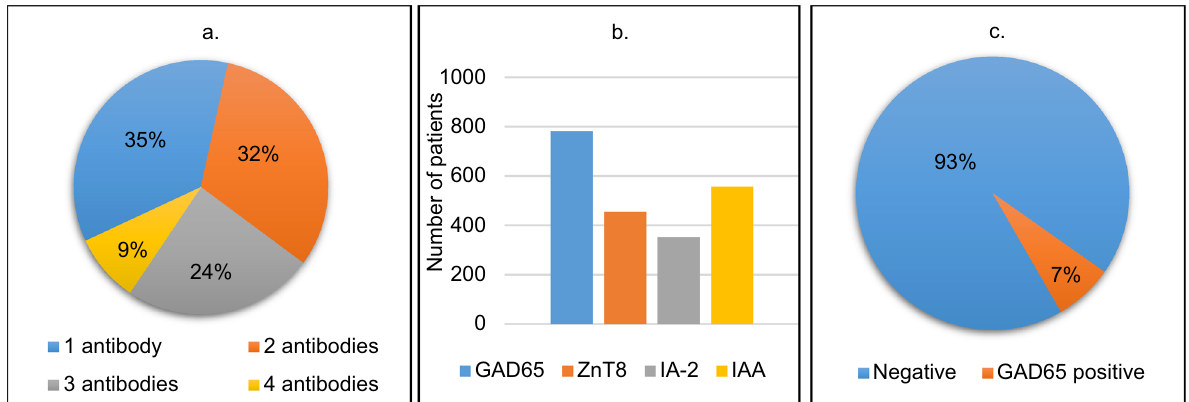
Figure 2. Summary of autoantibody assay on type 1 diabetes mellitus patients. ( a ) Number of type 1 diabetes mellitus patients with 4,3,2 and 1 autoantibody positive. ( b ) Type 1 diabetes mellitus patients with GAD, IA2, IAA and ZnT8 positive. ( c ) Autoantibody assay results in control subjects.